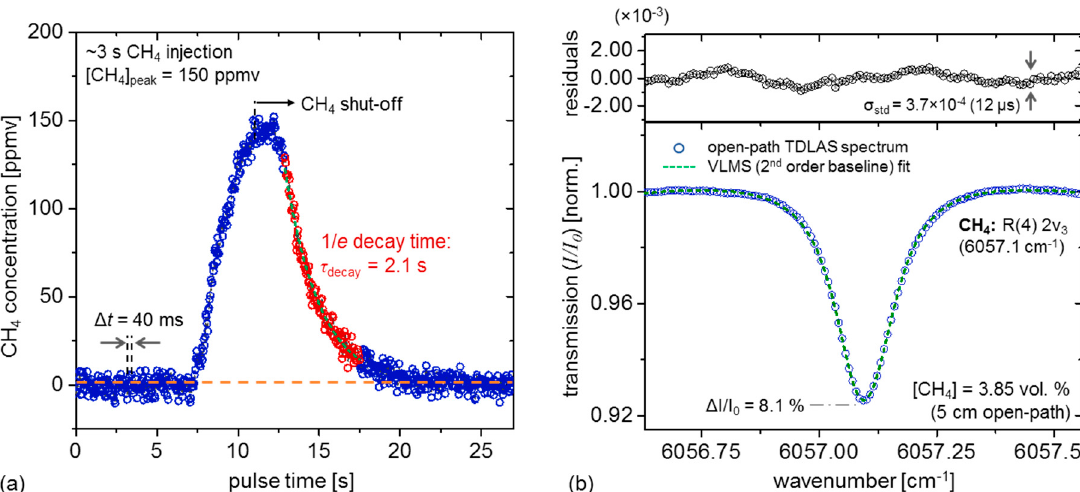
Figure 3. ( a ) Laboratory CH 4 release from a 1.0 vol.% CH 4 cylinder (air balance), measured in